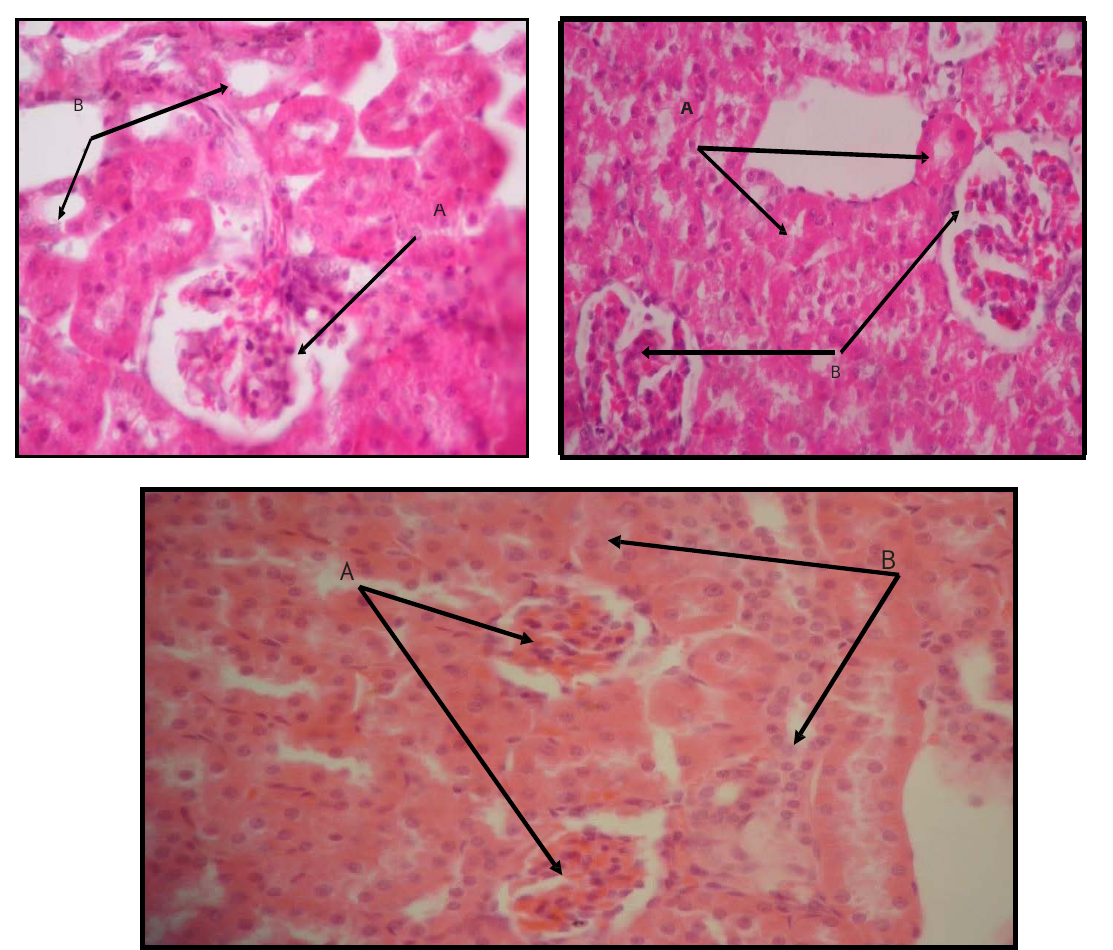
Figure (2): Figure (6): Section of kidney of (single dose 25mg/kg i.p.) DOX group reveals A) Moderate tubular epithelial cell swelling and vacuolation B) Glomerular congestion. H & E